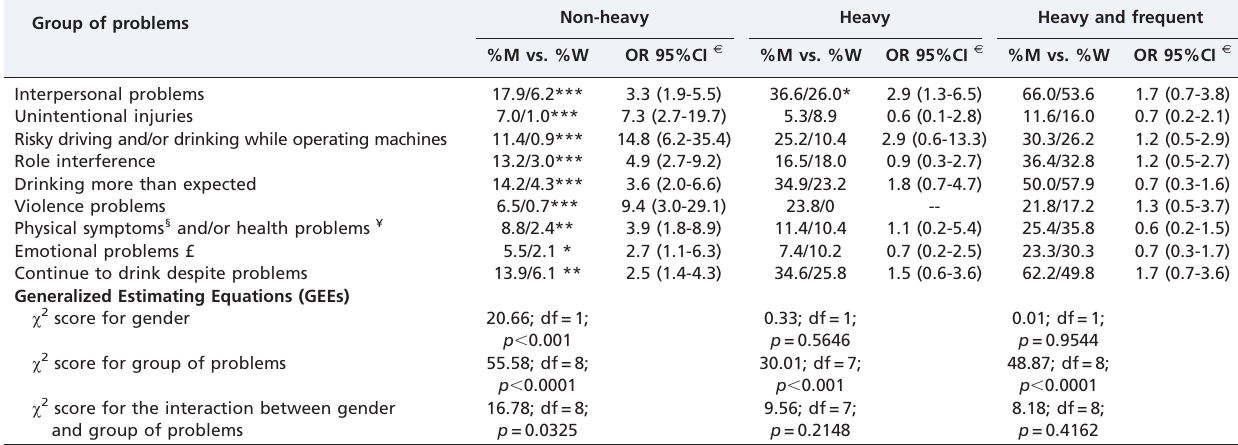
Table 3 - Percentage of alcohol-related problems stratified by drinking pattern. Wald x 2 test for men/women (M vs. W) differences; results are presented as odds ratio and 95% confidence interval (ORs, 95% CI) from the multivariate regression model with generalized estimating equations (GEEs) (SP-ECA; n =